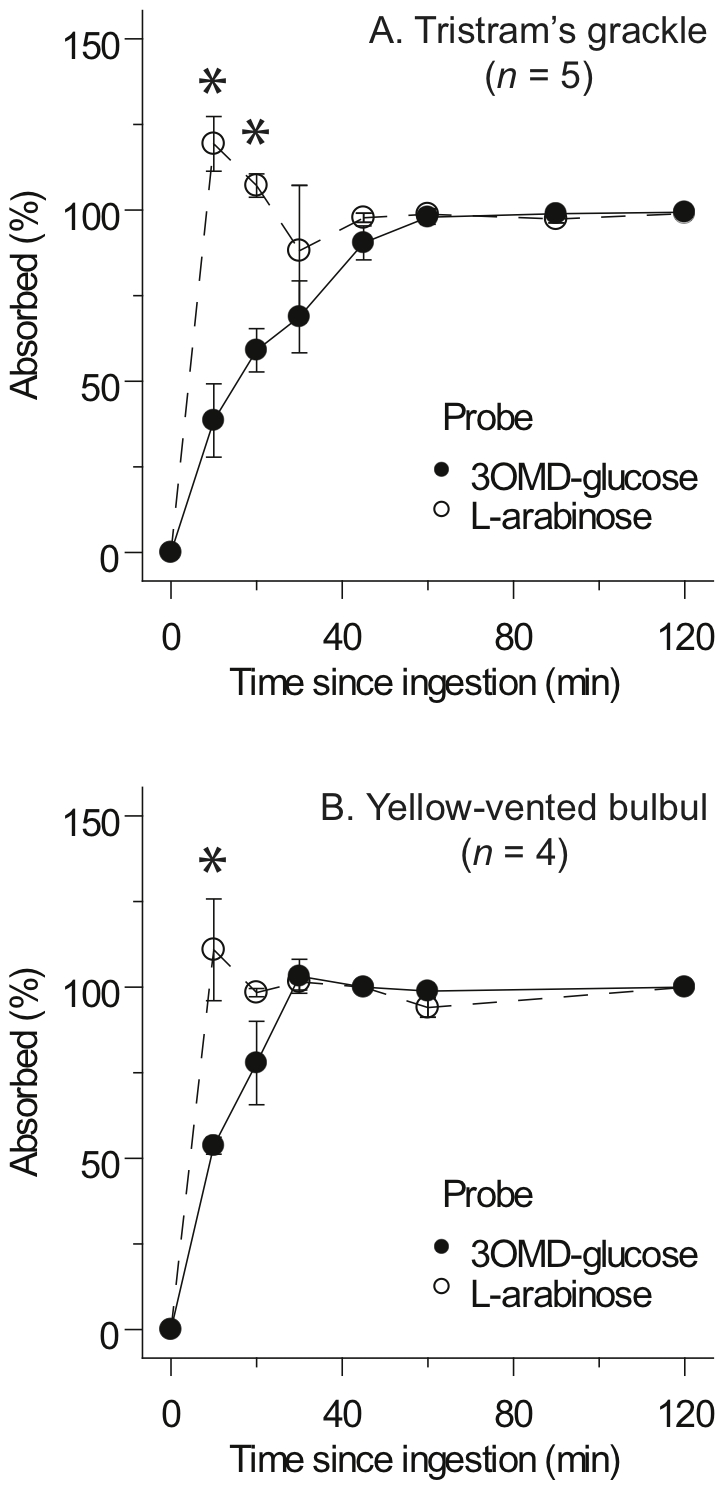
Cumulative absorption versus time since probe ingestion.Data for 3-O-methyl-D-glucose (3OMD-glucose) are denoted by filled circles and solid lines; L-arabinose data are represented by empty circles and broken lines. Cumulative absorption data for Tristram's grackles and yellow-vented bulbuls are shown in panels A and B, respectively. By an hour or less post-ingestion, the absorption of both compounds was essentially complete, but at early time points the absorption of L-arabinose significantly exceeded that of 3OMD-glucose, as indicated by an asterisk (P<0.05; paired t-test). Values are means (± SEM) calculated from measurements on individual animals.